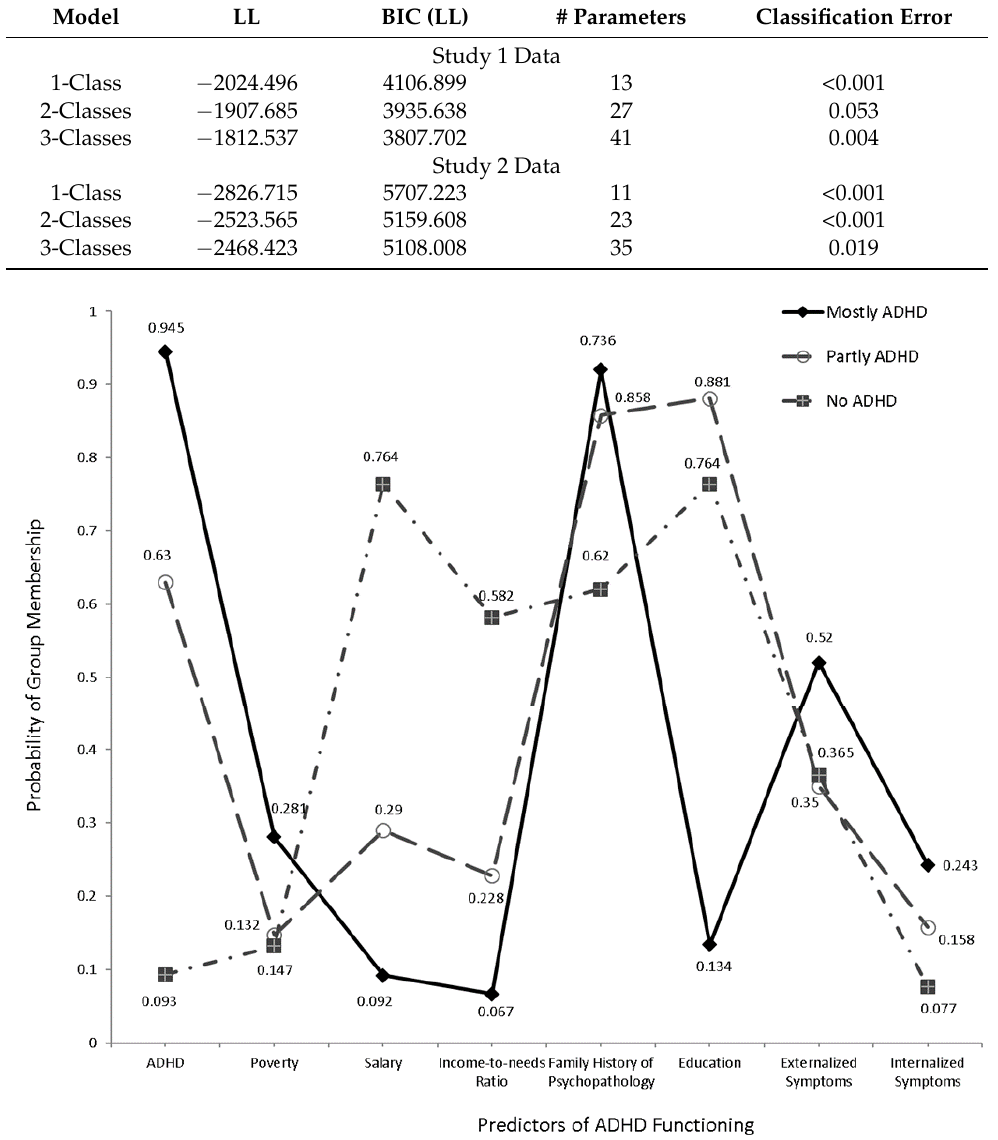
Figure 1. Three-Class latent class model using Study 1 data.